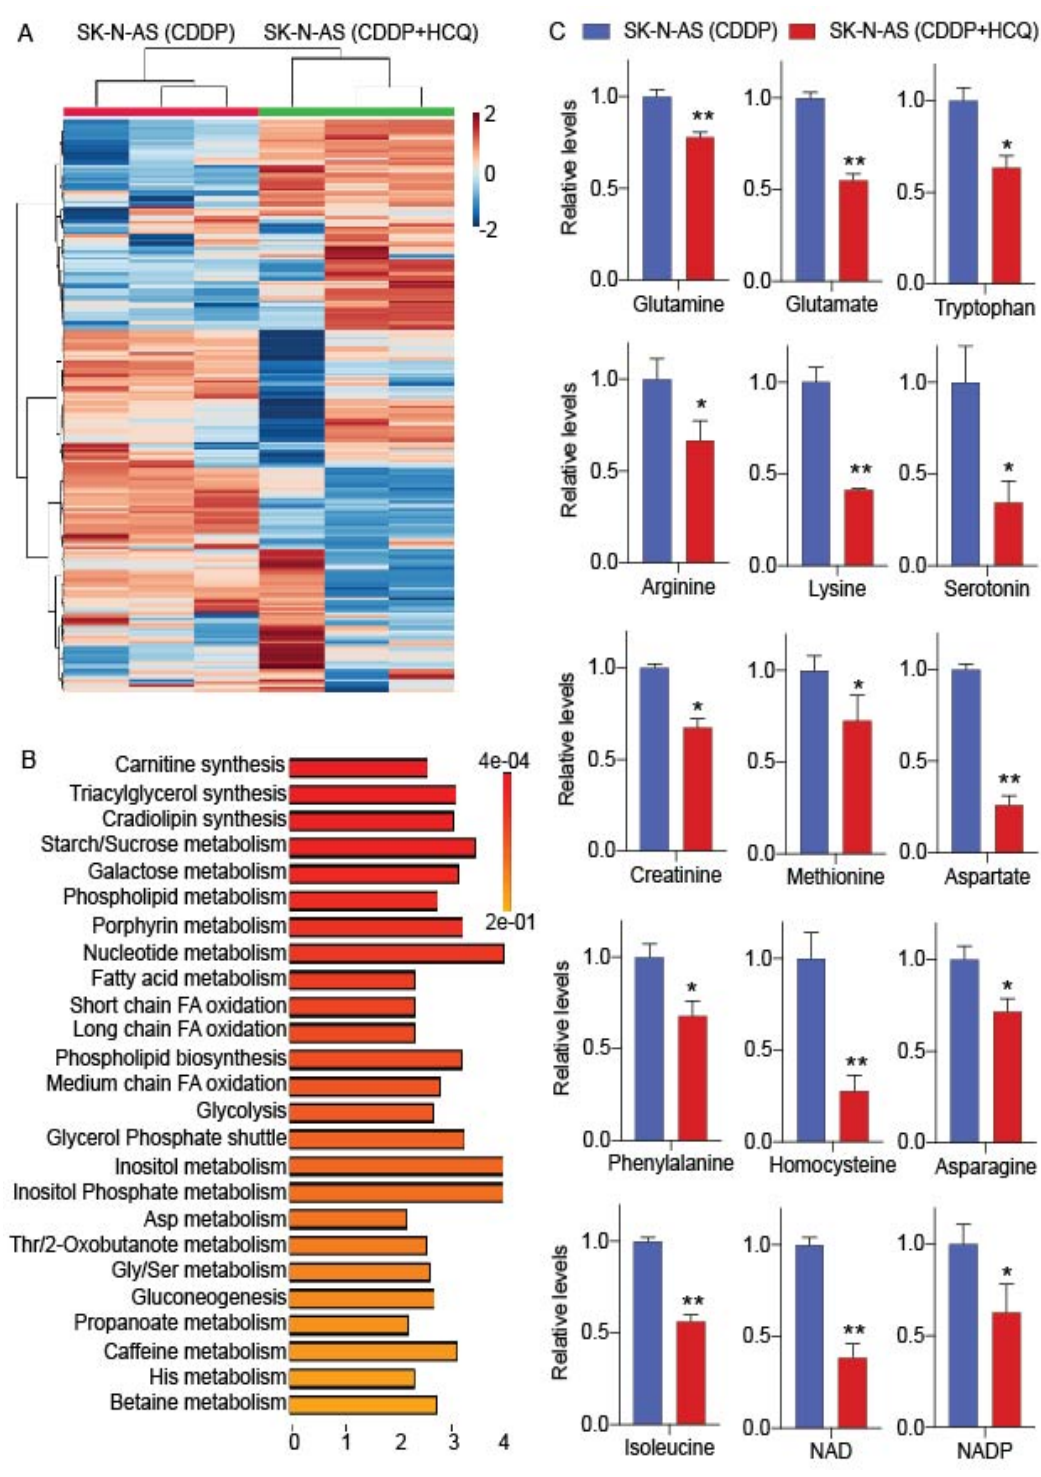
Figure 5. Hydroxychloroquine (HCQ) inhibits cisplatin-induced amino acid metabolism. ( A ) Heatmap showing alterations in metabolic pathways in cisplatin-insensitive cells treated with CDDP and CDDP + HCQ media for 24 h. Colored cells in row represent the alterations in individual metabolites. Scale for heatmap is shown adjacent to the heatmap; ( B ) pathway impact analysis showing significantly impacted pathways in HCQ + CDDP treated cells in comparison to CDDP treated SK-N-AS cells. Scale under